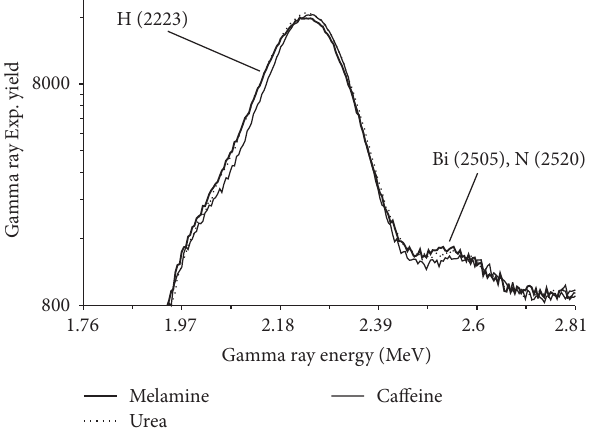
Figure 7: Enlarged lower energy suppressed prompt gamma ray experimental pulse height spectra of BGO detector from caffeine, melamine, and urea samples over 1.76–2.81 MeV showing hydrogen capture peak along with unresolved 2.50 and 2.52 MeV bismuth and nitrogen peaks,